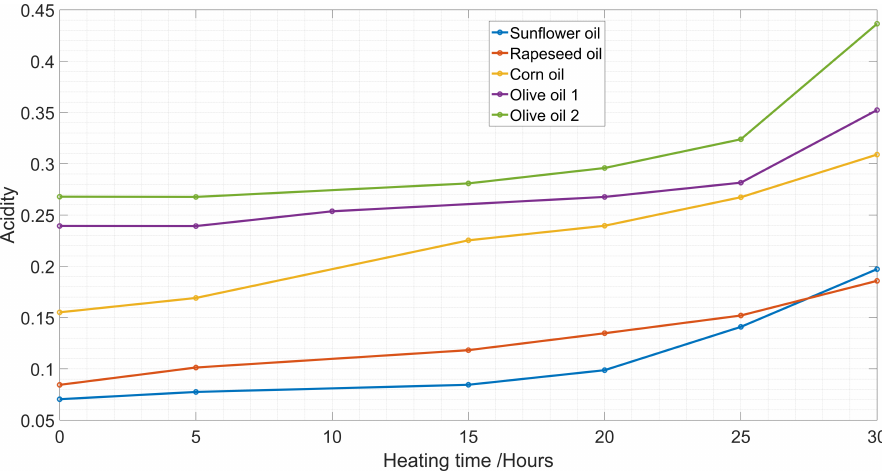
Figure 1. Increase of acidity with heating